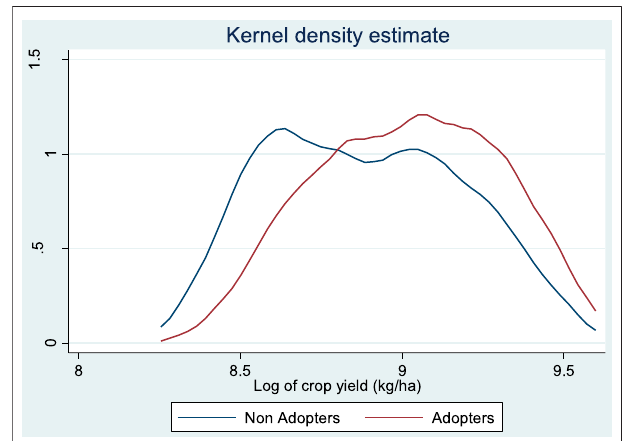
FIGURE 1 | Distribution of crop yield (log) between adopters and non-